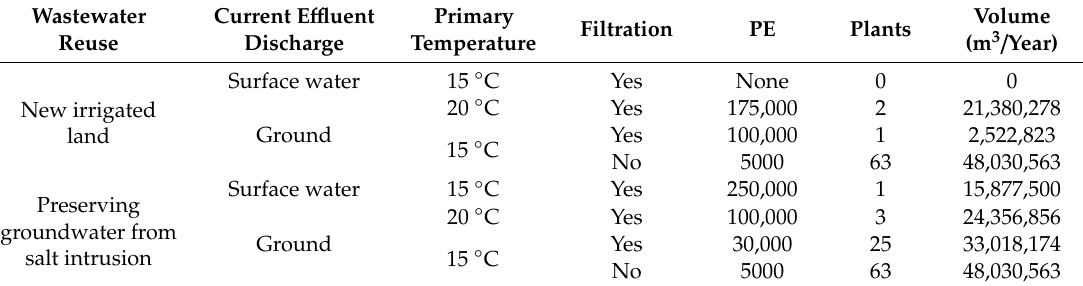
Table 6. Economically feasible reclaimed urban wastewater volume in Puglia